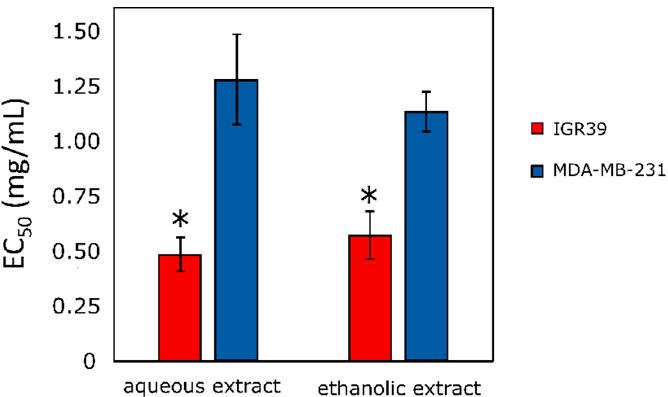
Figure 7. EC 50 values of C. sativus perianth extracts against MDA-MB-231 and IGR39 cell lines after 72 h, * p < 0.05, n = 3.